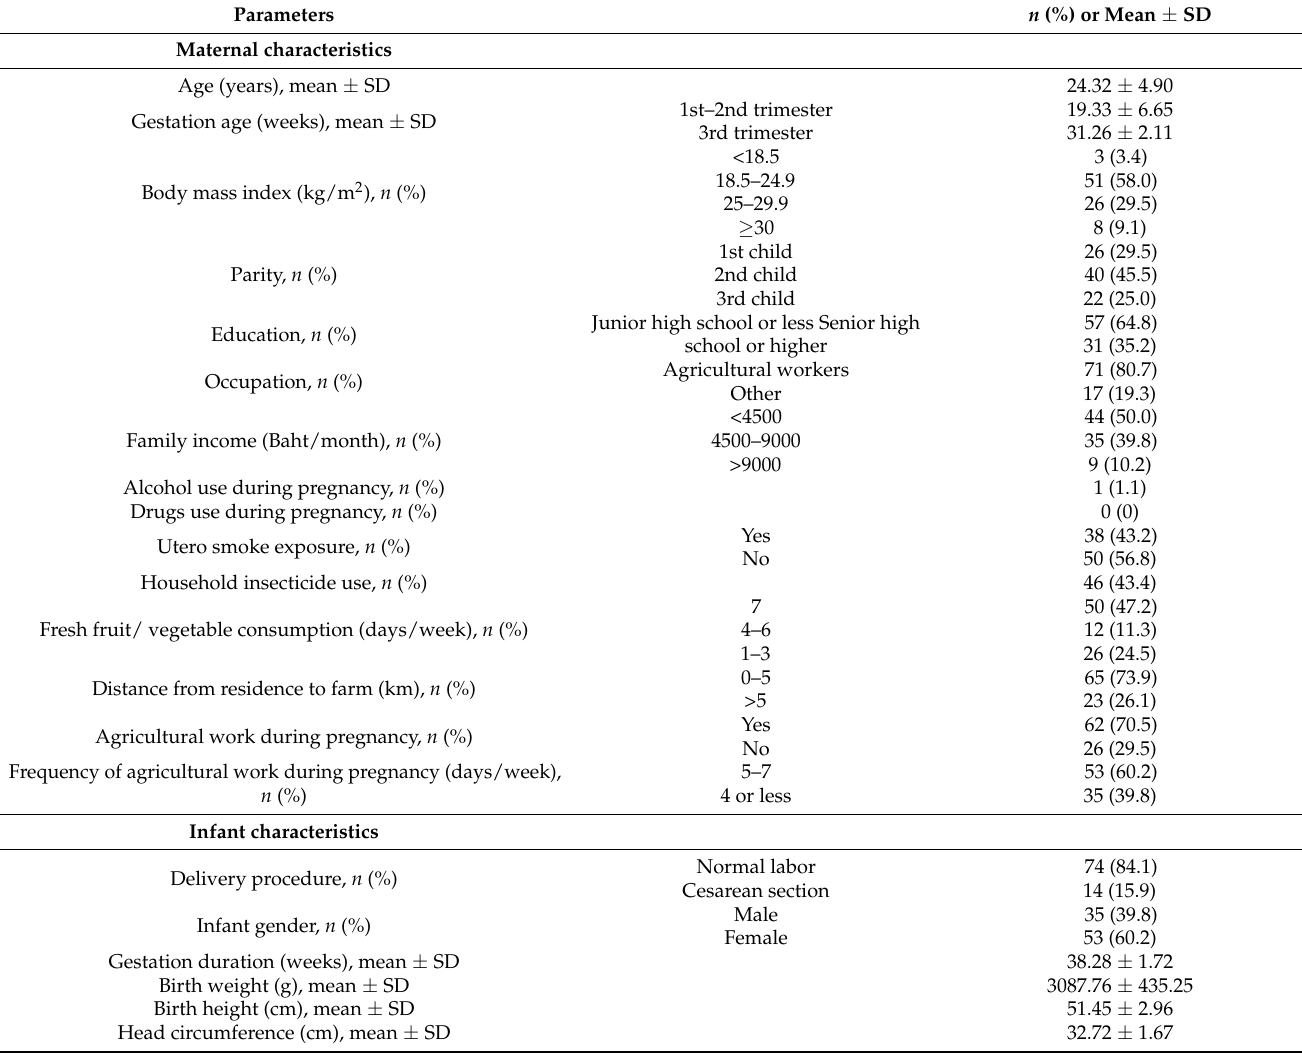
Table 1. Demographic data of the mothers and infants in the agricultural community ( n =